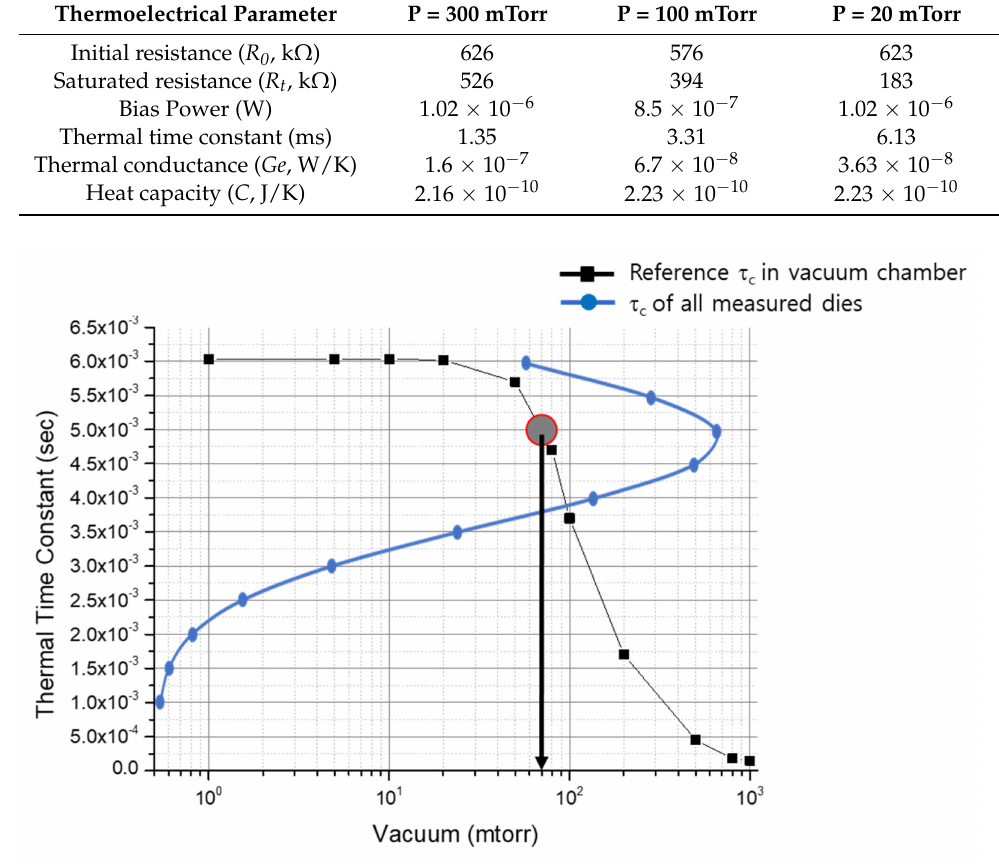
Figure 10. Distribution of thermal time constant of wafer-level packaged samples overlaid on a τ -P curve.